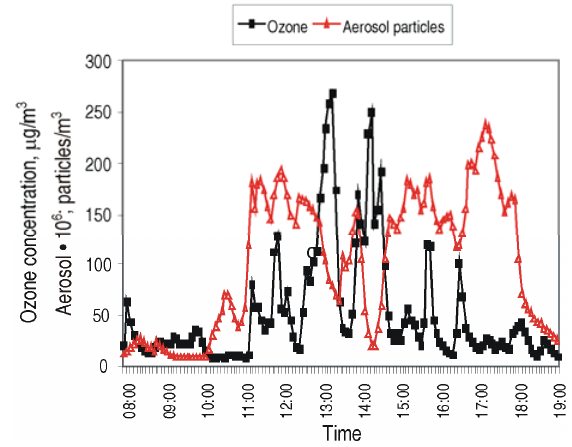
Fig. 7. Relationship between ozone concentration and temperature gradient, January 10